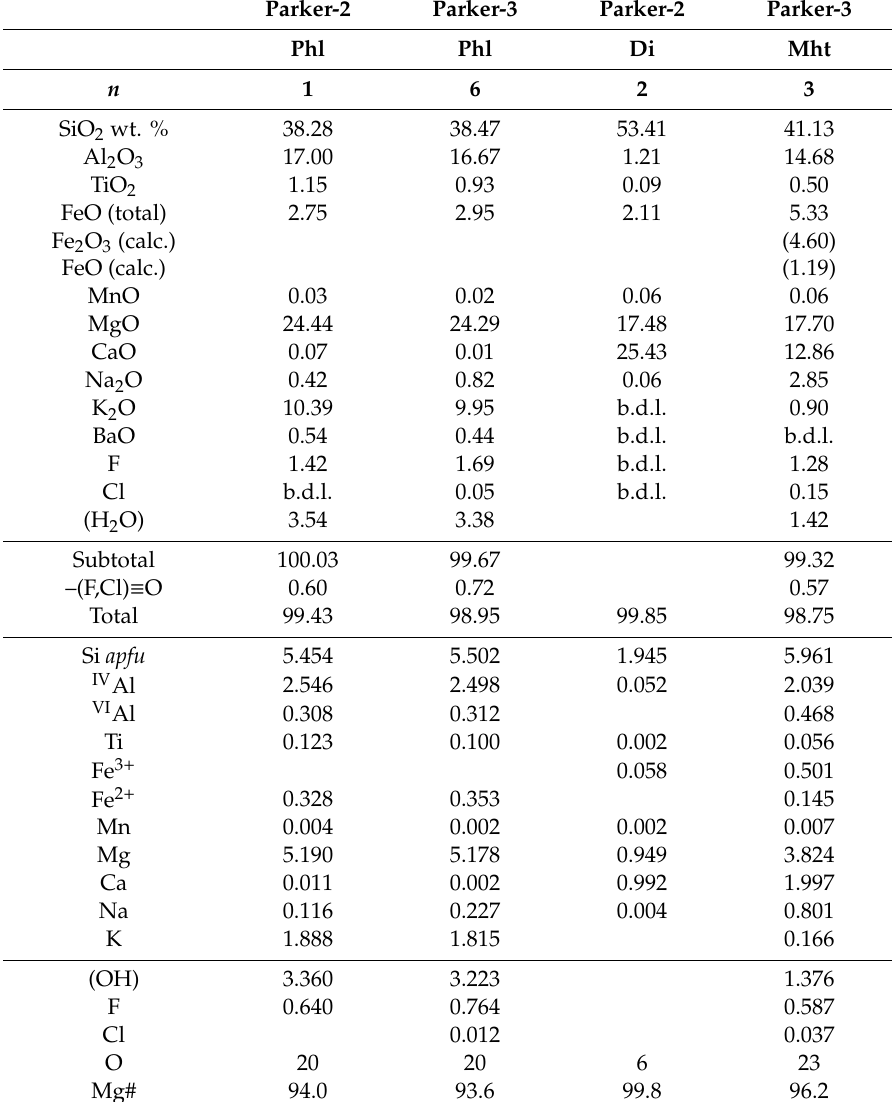
Table 3. Composition of phlogopite, magnesio-hastingsite, and diopside, Parker phlogopite mine, Notre-Dame-du-Laus, Qu é